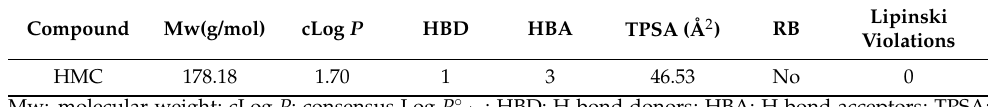
Table 6. Physicochemical parameters and Lipinski